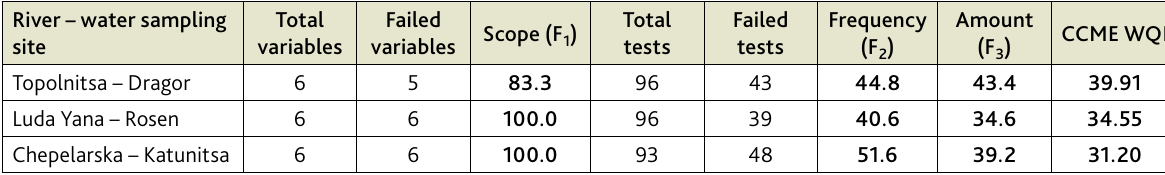
Table 7. Descriptive statistics of the metalloid and trace metal concentration (µg/l) in surface waters River – water sampling point